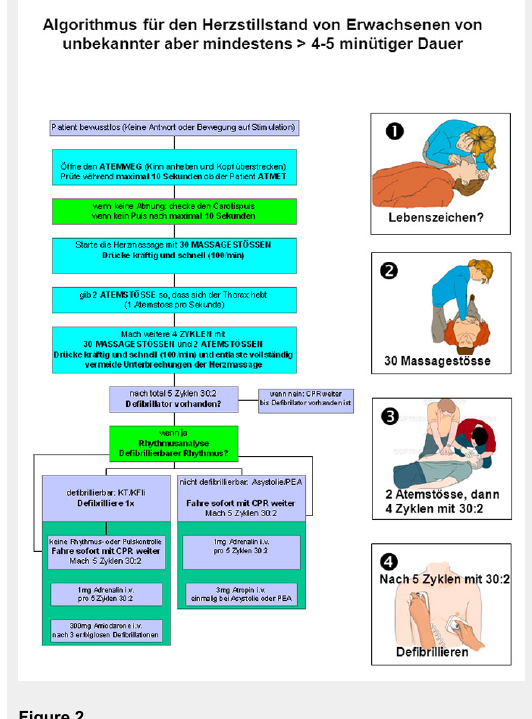
Instruction of the CAB algorithm corresponding to the 2005 guidelines of the European Resuscitation Council [6]. The instruction includes illustrations from the electronic version of the 2005 guidelines of the American Heart Association [8] and the European Resuscitation Council [6]. Reprint with permission of the publishers.